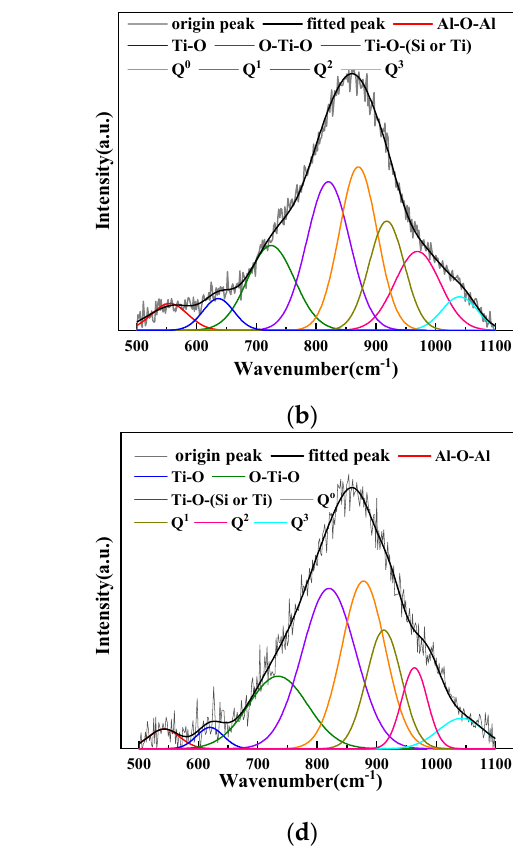
Figure 10. Raman spectra of slag with varying MgO/Al 2 O 3 : ( a ) MgO/Al 2 O 3 = 0.40; ( b ) MgO/Al 2 O 3 = 0.48; ( c ) MgO/Al 2 O 3 = 0.56; ( d ) MgO/Al 2 O 3 = 0.66.